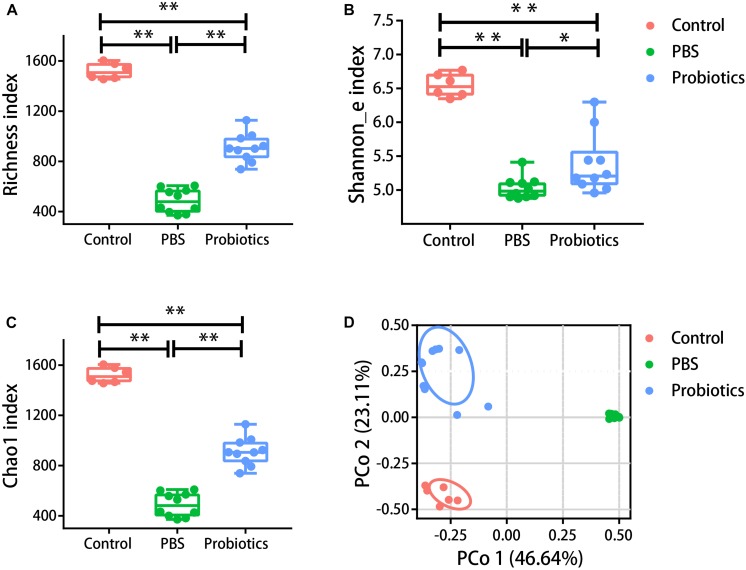
The α- and β-diversity of the gut microbiota were different among three groups. Mouse feces were collected and DNA was extracted for 16S rRNA gene sequencing 10 days post-infection. Analysis of the 16S rRNA gene sequences (variable regions 4) derived from the fecal pellets of the control group (n = 6), PBS group (n = 10), and probiotics group (n = 10). (A–C) Represent the Richness index, Shannon_e index, and Chao1 index, respectively. Probiotics treatment significantly increased the levels of the Richness index, Shannon_e index, and Chao1 index compared to the PBS treatment. The data were analyzed using one-way ANOVA (P < 0.05). (D) Is the PCoA plot of the intestinal microbiota based on unweighted UniFrac metrics. The data were analyzed using nonparametric MANOVA based on Adonis (P < 0.05). PCO 1 accounted for 46.64% of the variation, and there were no significant differences between the control and probiotics groups in PCO 1. The data were analyzed using Kruskal-Wallis test (P < 0.05). ∗P< 0.05, ∗∗P< 0.01.